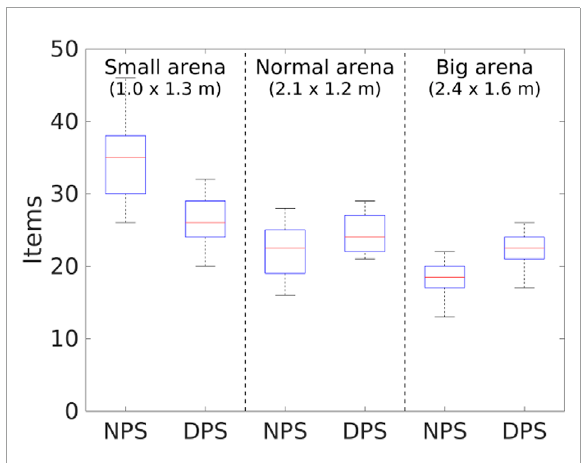
FIGURE 21 Item collection with physical robots and different arena sizes. The DPS starts to overcome the NPS as the arena size